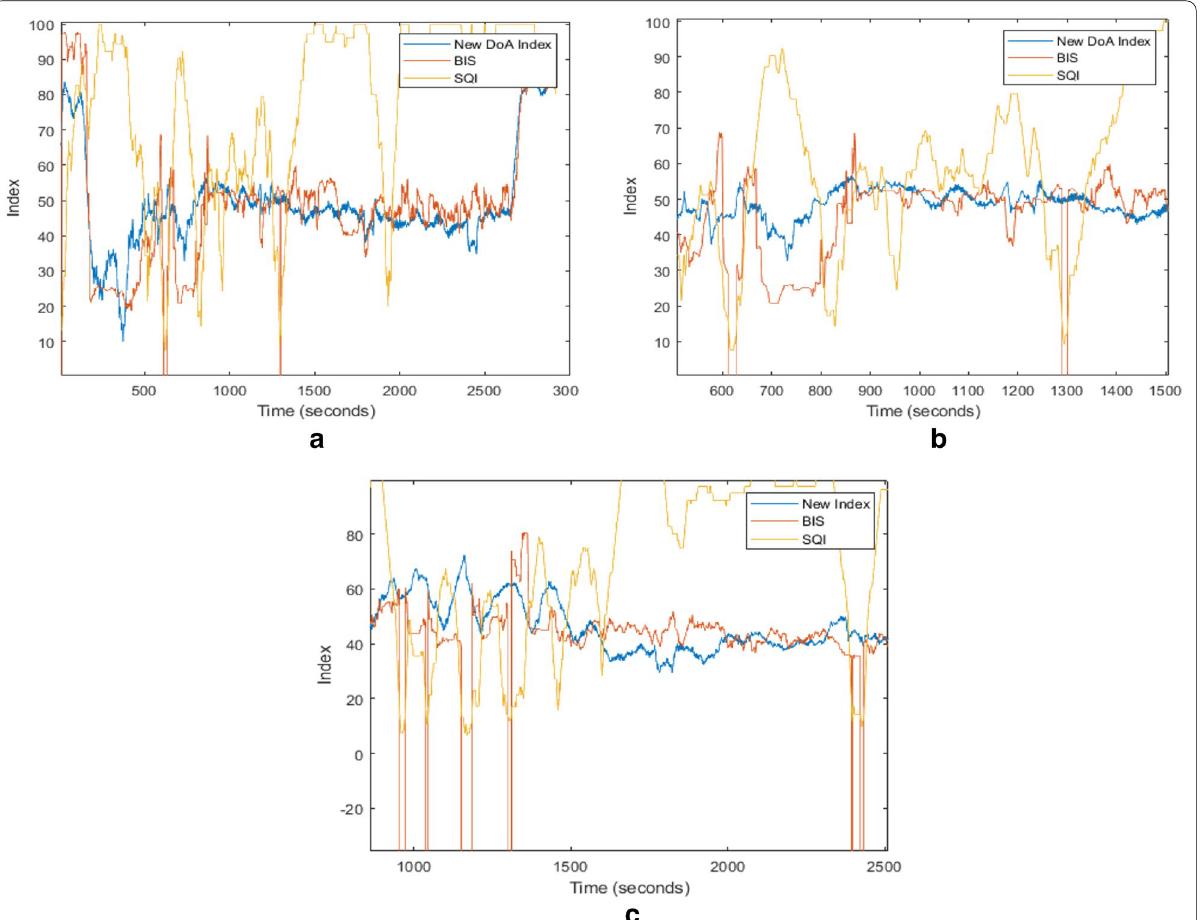
Fig. 10 Comparisons of the new index and the BIS index with SQI. a . Patient ID: 19 range: 0–3000 s; b Patient ID: 19, range: 500–1500 s; c Patient ID: 25, range: 800–2300